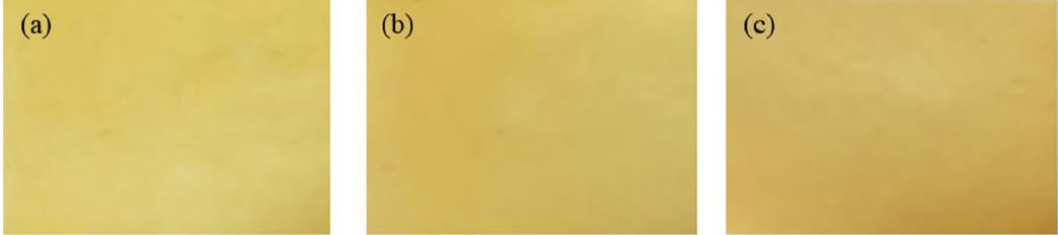
Figure 6. The appearance of Averrhoa bilimbi pectin (ABP)-based edible film (EF) extracted using choline chloride–citric acid monohydrate-based deep eutectic solvent (DES) at molar ratios of 3:1, 1:1 and 1:3—( a ) EF-ABP3:1, ( b ) EF-ABP1:1, and ( c ) EF-ABP1:3. Reproduced with permission from [28]. (Copyright 2020 Elsevier).